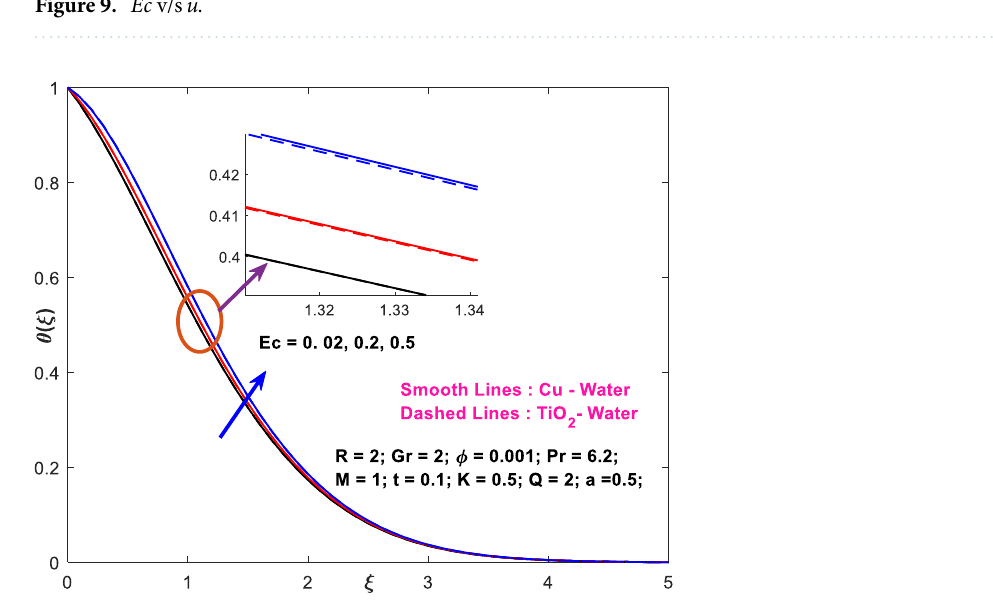
Figure 10. Ec v/s θ